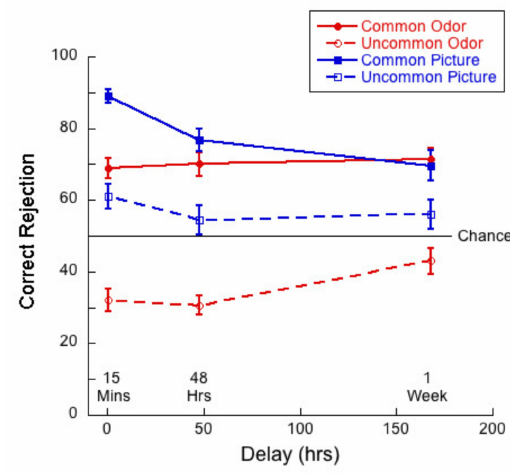
Figure 6. Correct rejection rate as a function of delay for each of the four test